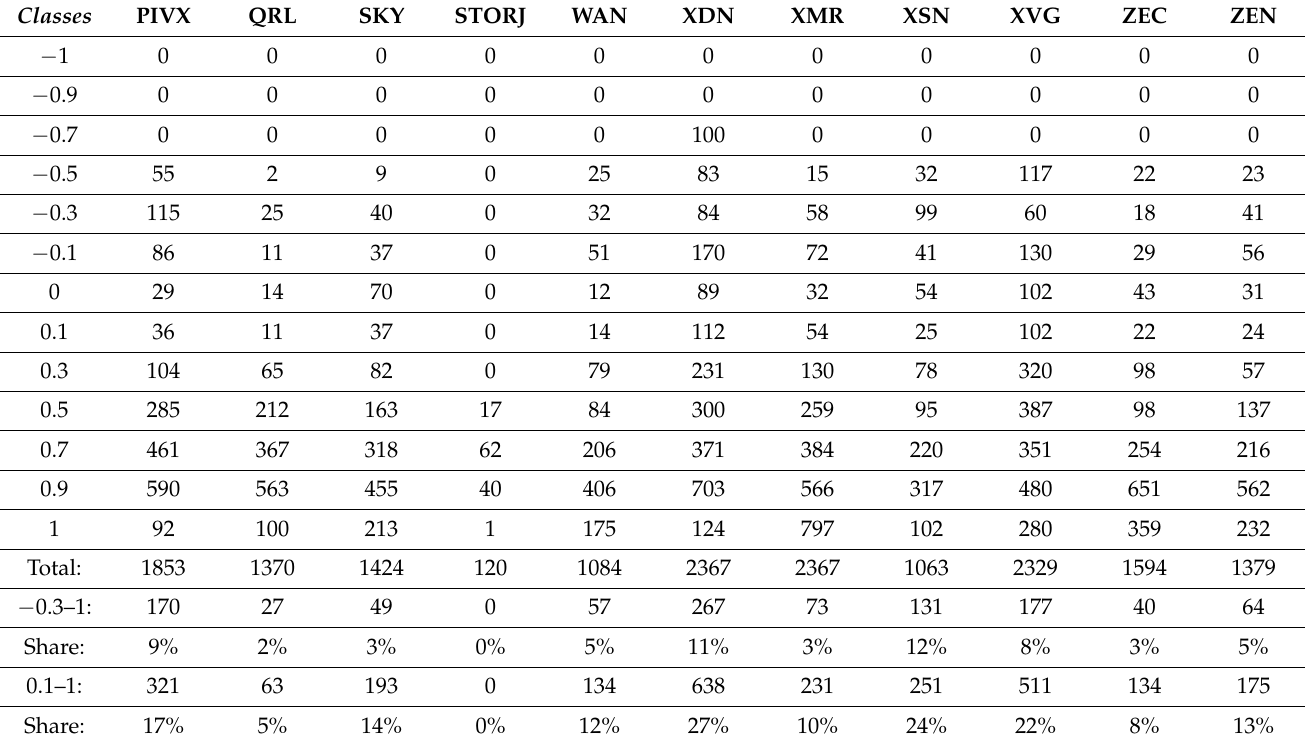
Table 6. Rolling 100 days correlation distribution in different correlation classes (continued; 0.2 correlation is below p value of 0.05, and 0.26 is below p value of